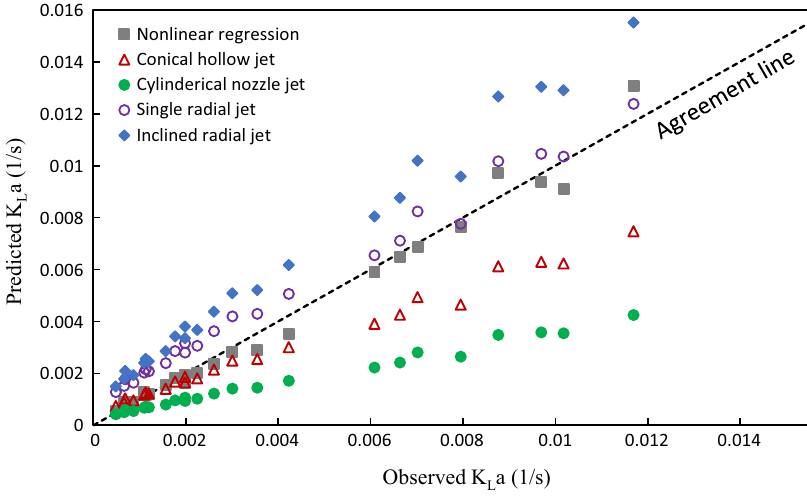
Fig. 12 Experimental versus predicted values of K L a by non- linear regression (Eq. 12) and previous studies on jet aerators with the testing data set